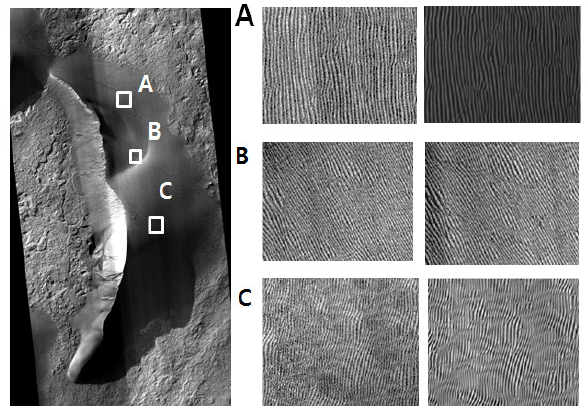
Figure 8 . Ripple structures migration after photogrammetric